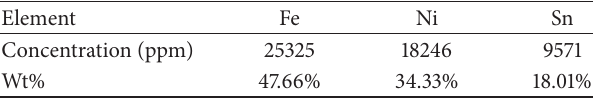
Table 1: Analysis of IC lead frame scraps by ICP.